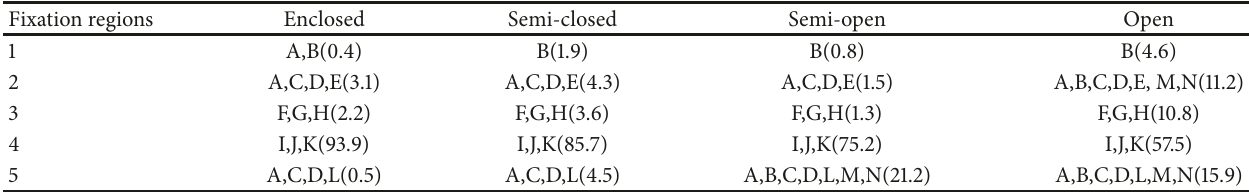
Table 2: Targets in five regions and percentage of drivers’ visual fixations in five regions in different highway landscapes. Fixation regions